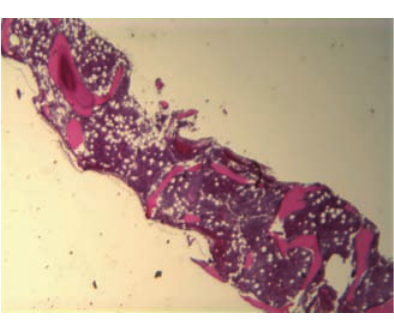
Figure 3. Extensive bone marrow involve- ment by